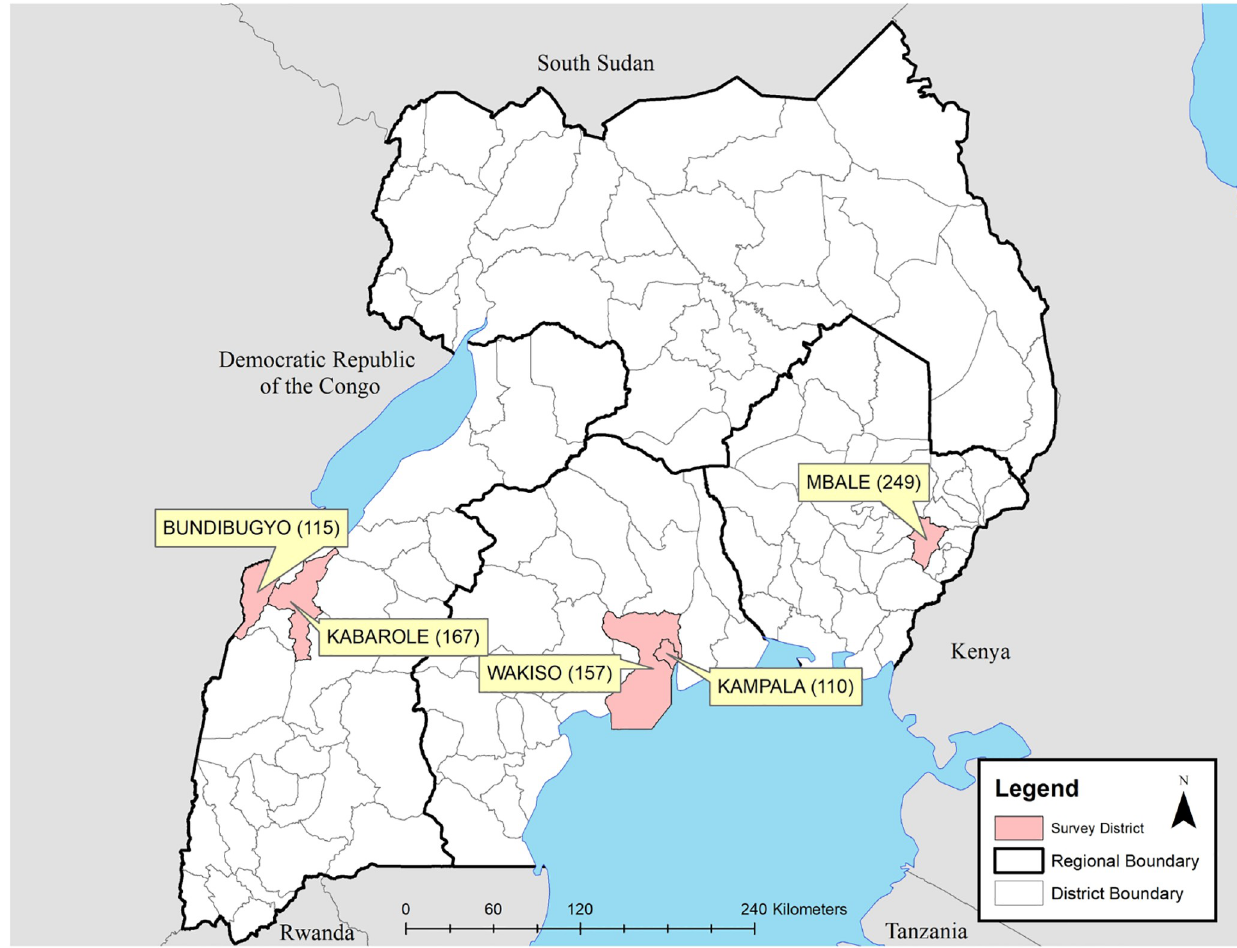
Fig 2. Districts and number of households surveyed in Uganda. Administrative boundaries were obtained from www.gadm.org.